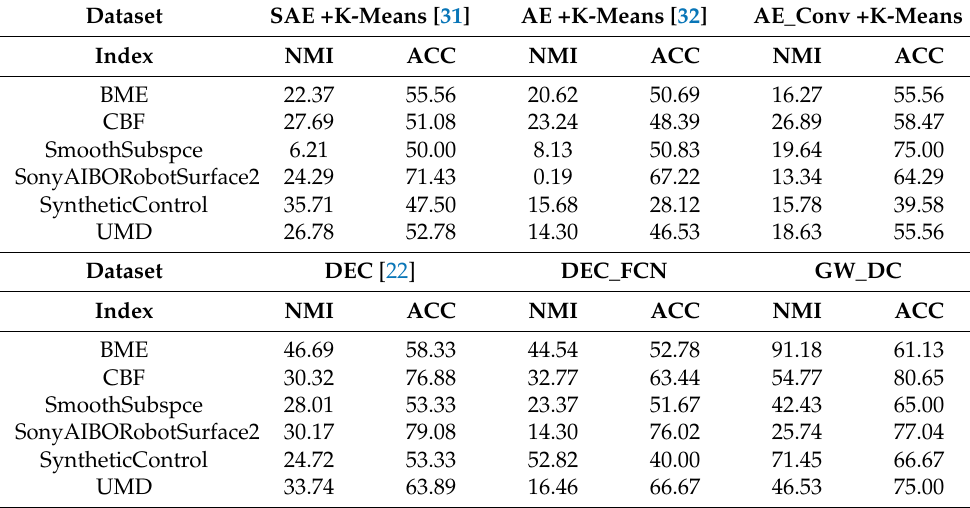
Table 3. Results of different deep clustering